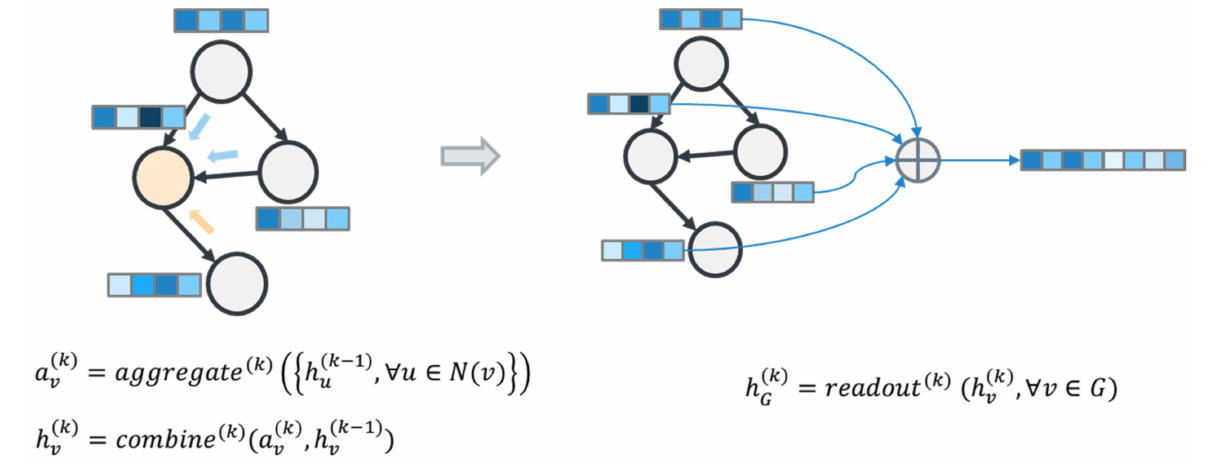
Figure 5. GNN learning strategy.